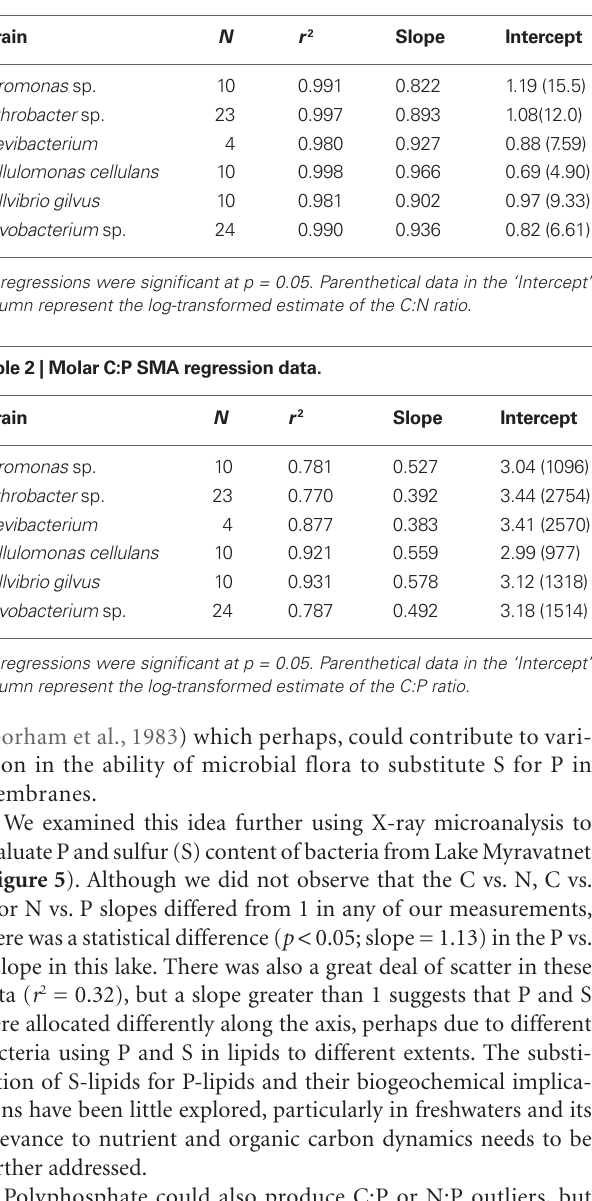
Table 1 | Molar C:N SMA regression data.